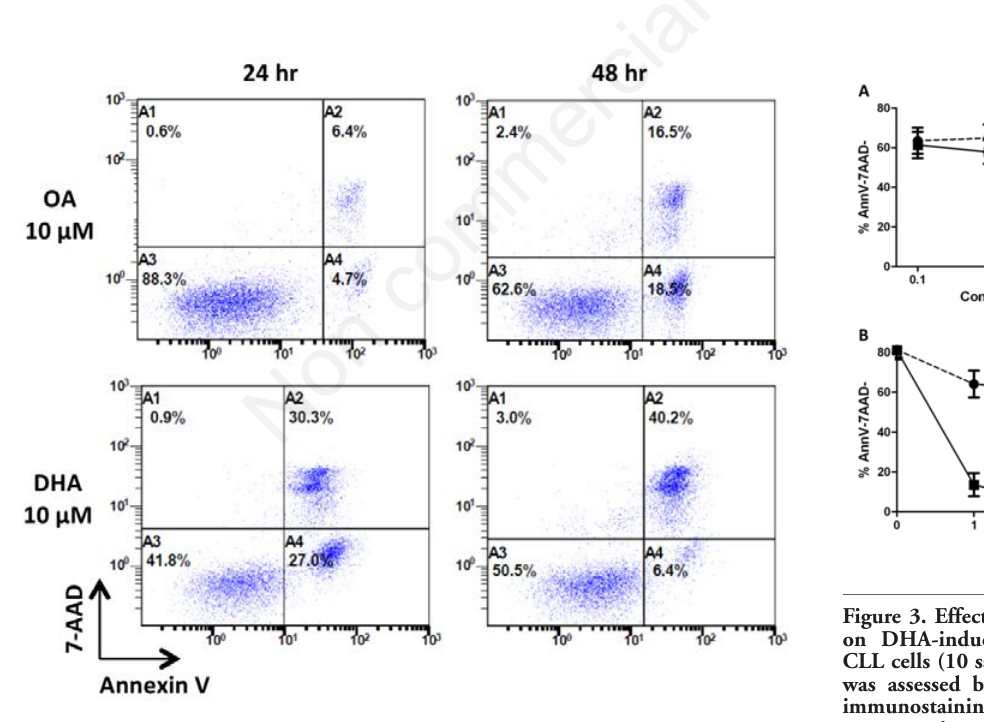
Figure 1. Effects of OA 10 µM and DHA 10 µM on apoptosis of the Ramos cell line (rep- resentative experiment). Ramos cells viability was assessed by Annexin V-FITC/7-AAD immunostaining after exposure to OA and DHA at 10 µM for 24 and 48 hours. Cells in the lower left quadrant (A3) correspond to viable cells (Annexin V-negative and 7AAD- negative), cells in the lower right quadrant (A4) correspond to early apoptotic cells (Annexin V-positive and 7AAD-negative), while cells in the upper quadrant (A2) corre- spond to late apoptotic cells (Annexin V-positive and 7AAD-positive). OA, oleic acid; DHA, docosahexaenoic acid.